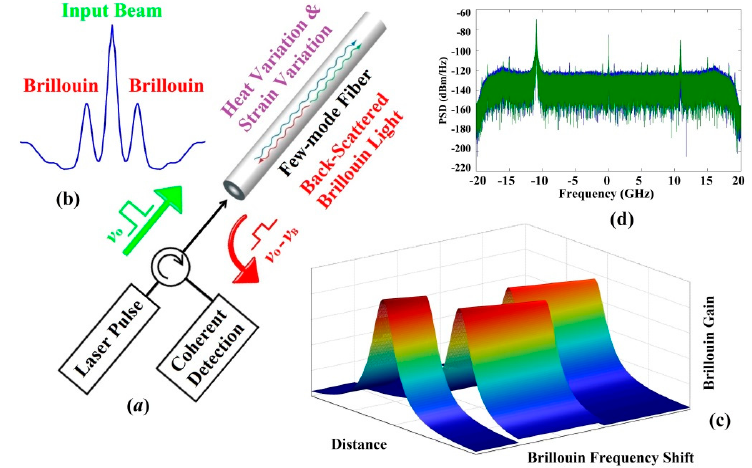
Figure 7. ( a ) Operational principle of optical sensing systems using FMF; ( b ) Schematic of the Brillouin frequency shifts; ( c ) 3D Brillouin gain spectrum with the temperature and/or strain variations; ( d ) Experimental Brillouin spectrum example for LP 01/11 modes.